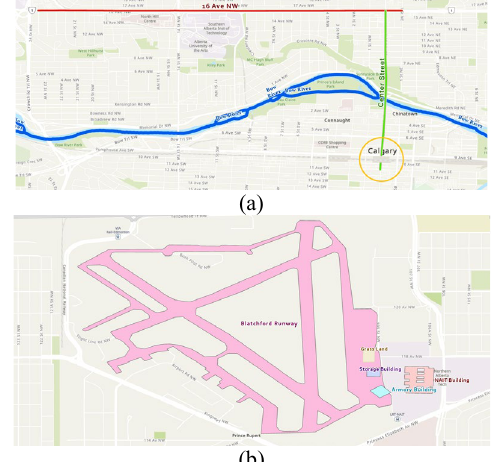
Figure 2 . (a)Fractured geometry Center Street at 1:50k resolution (circled), (b)Concave geometries: Blatchford Runway and NAIT